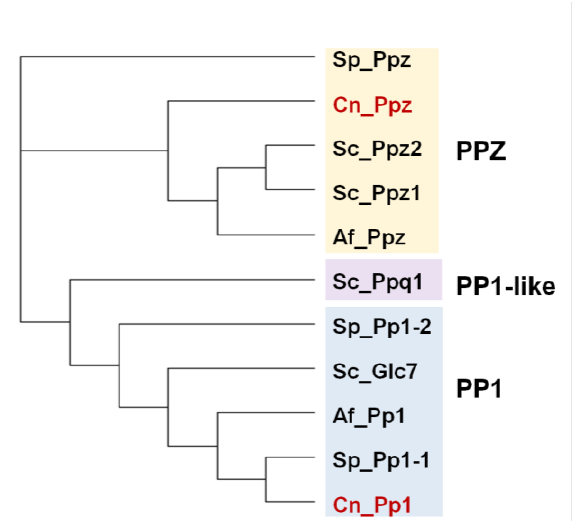
FIGURE 2: Phylogenetic tree of PP1 and PP1-like phosphatases from various fungal species. The protein sequences of the as- comycetes S. cerevisiae (Sc), S. pombe (Sp) and A . fumigatus (Af), as well as that of the basidiomycete Cryptococcus neoformans (Cn, in red) were used. Analysis was performed as in Figure 1. The corresponding sequence codes can be found in Supple- mental Table